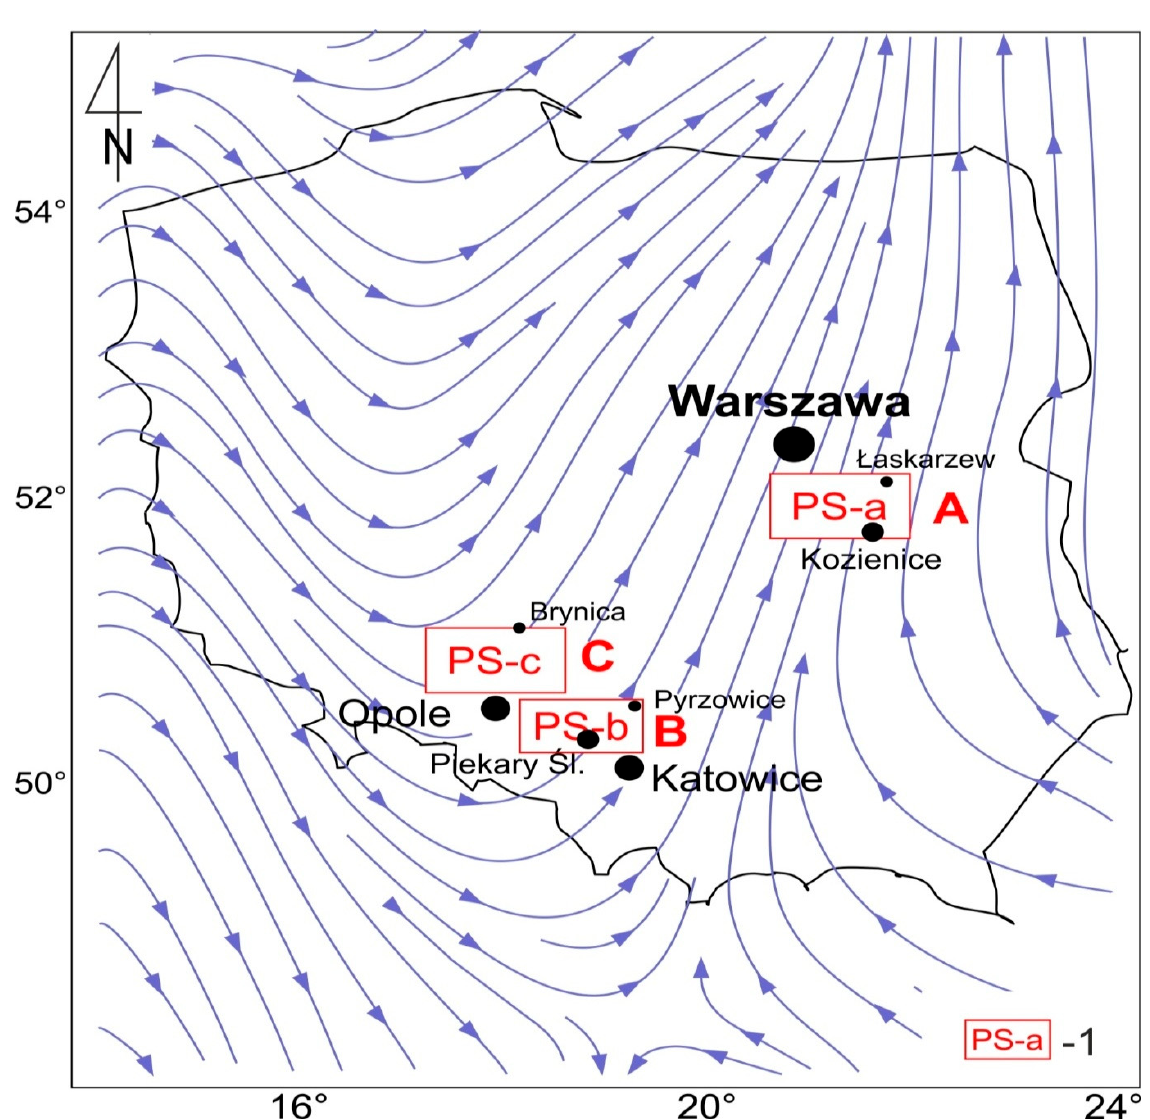
Figure 1. Location of research areas and power plants in comparison with the main wind directions in Poland (after: [90]). 1—power station in areas (e.g., A; there is no consent to enter the name).